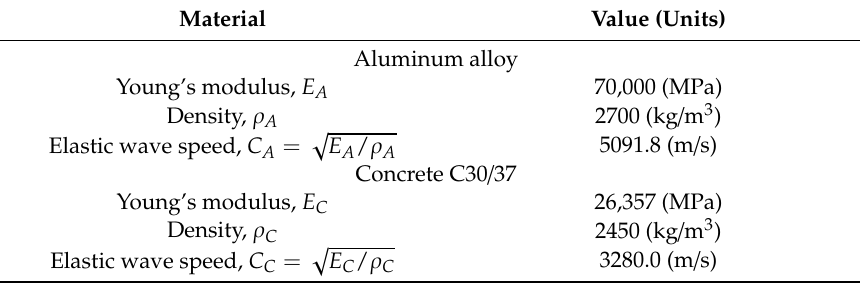
Table 2. Material parameters of the experimental setup from Figure 1.